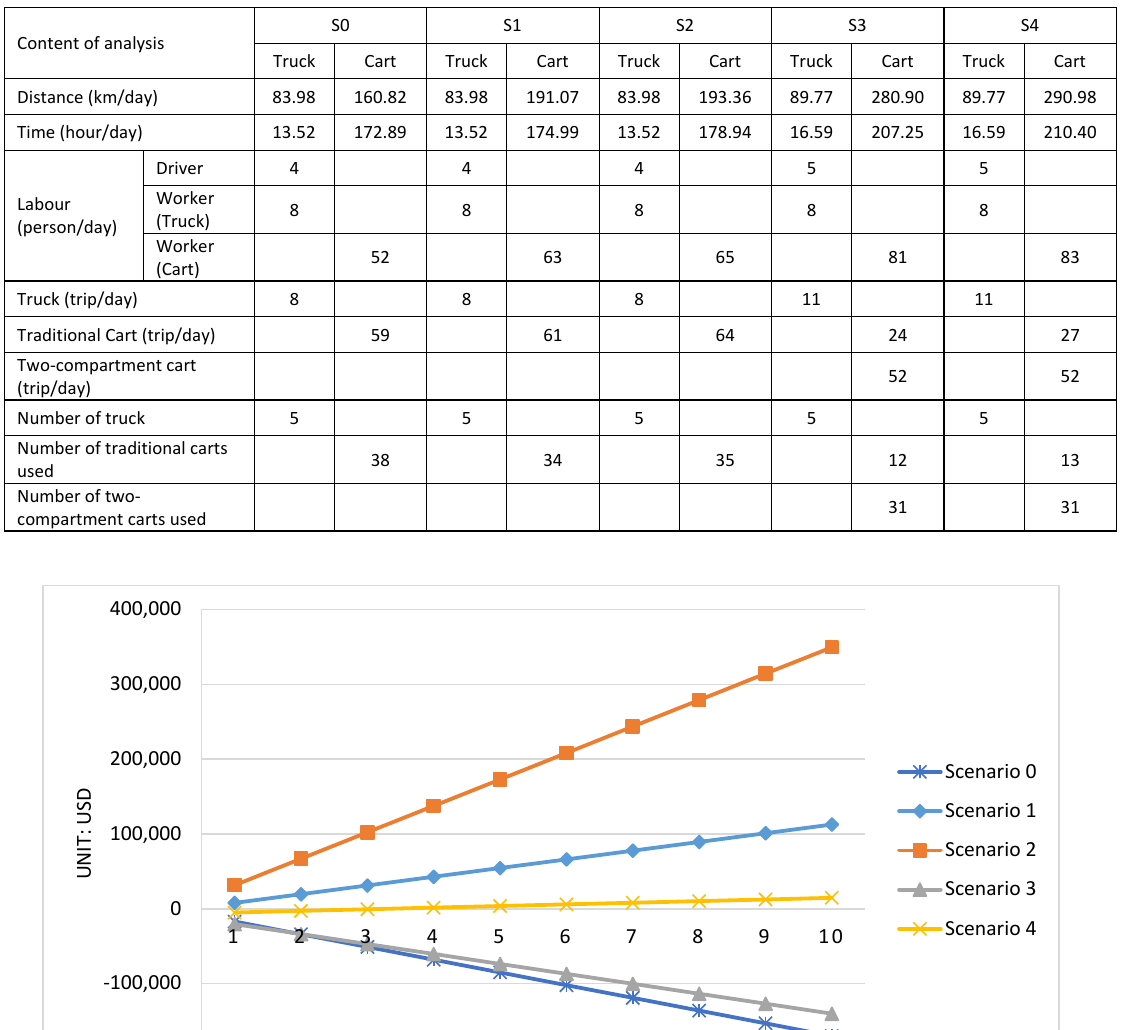
Table 2: The information for the solid waste collection by scenarios